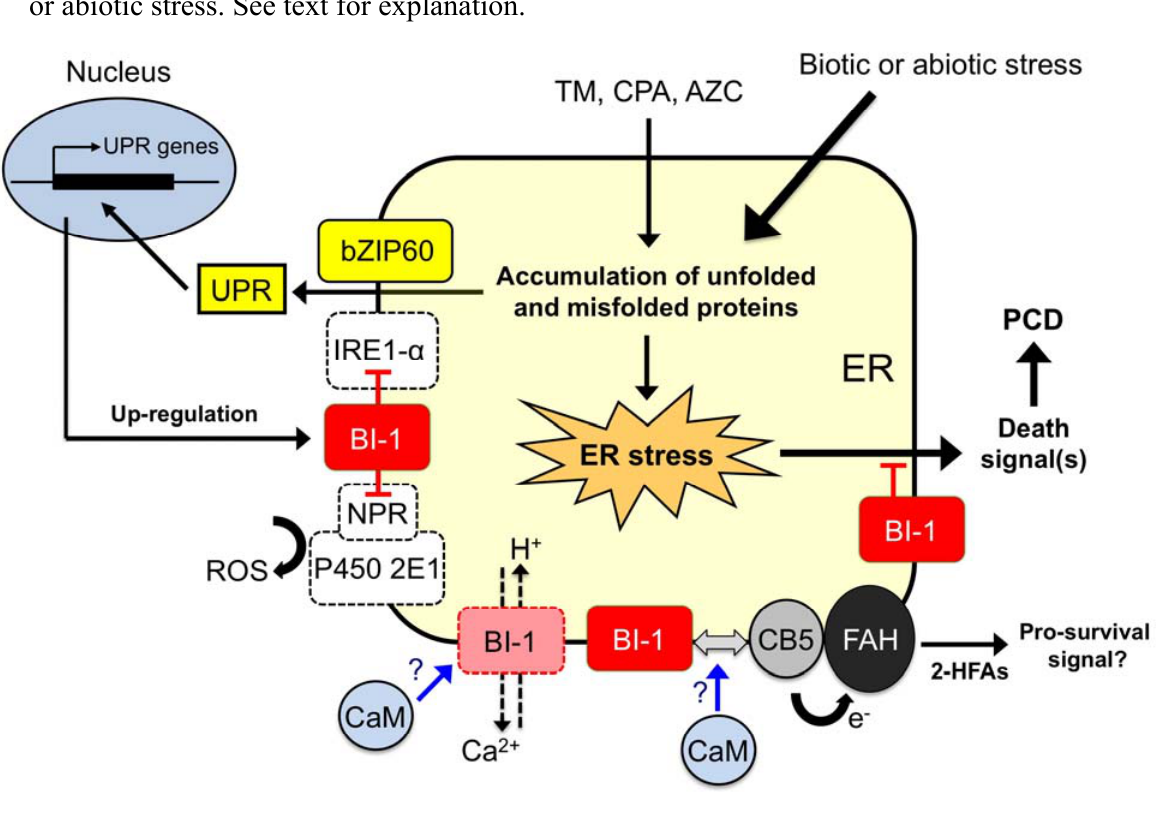
Figure 2. Working model of plant BI-1 in the control of PCD induced by ER stress, biotic or abiotic stress. See text for